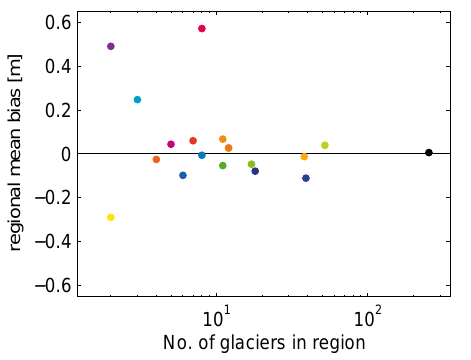
Fig. 10. Cross-validation results; regional mean model bias as a function of the number of glaciers situated in the region; black dot indicates the global mean.